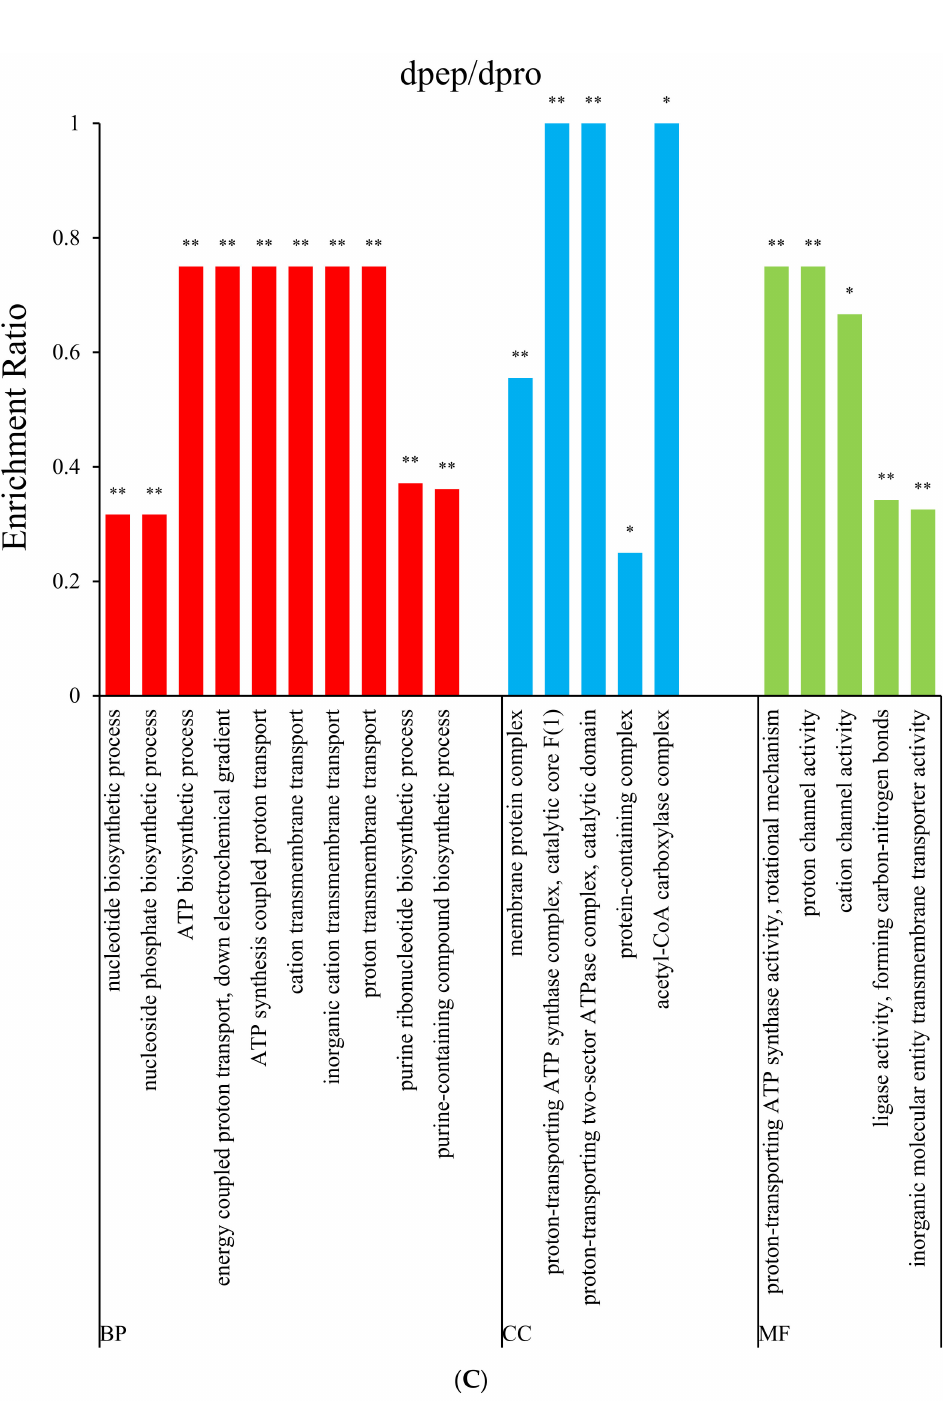
Figure 3. GO enrichment analysis of DEGs under different comparisons ( n = 3): ( A ) dpep/MRS; ( B ) dpro/MRS; ( C ) dpep/dpro. BP: Biological process; CC: Cellular Component; MF: Molecular Function. Enrichment ratio refers to the number of genes annotated to the GO term in the gene set to the number of genes annotated to the GO term. The significance of enrichment is determined by the p value, in which p < 0.001, <0.01 and <0.05 marked as ***, **, and *,